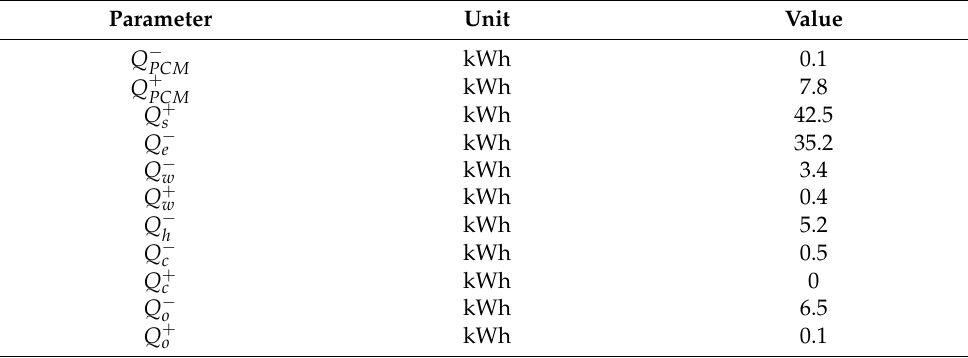
Table 7. Summary of heat values during the occupation period (6 a.m.–6